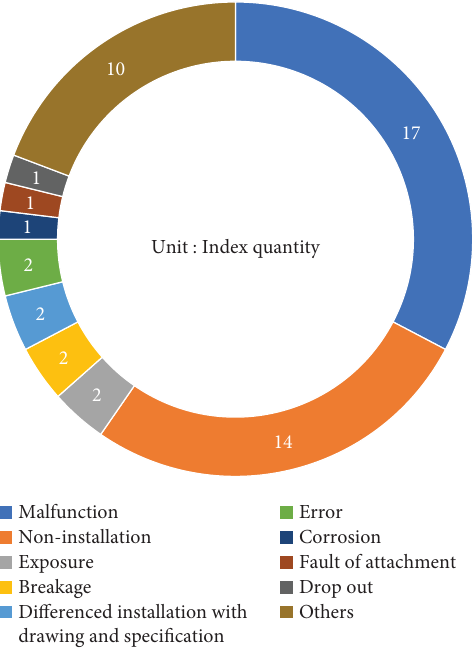
Figure 6: Distribution on phenomena.